Question: Describe this figure in one sentence.
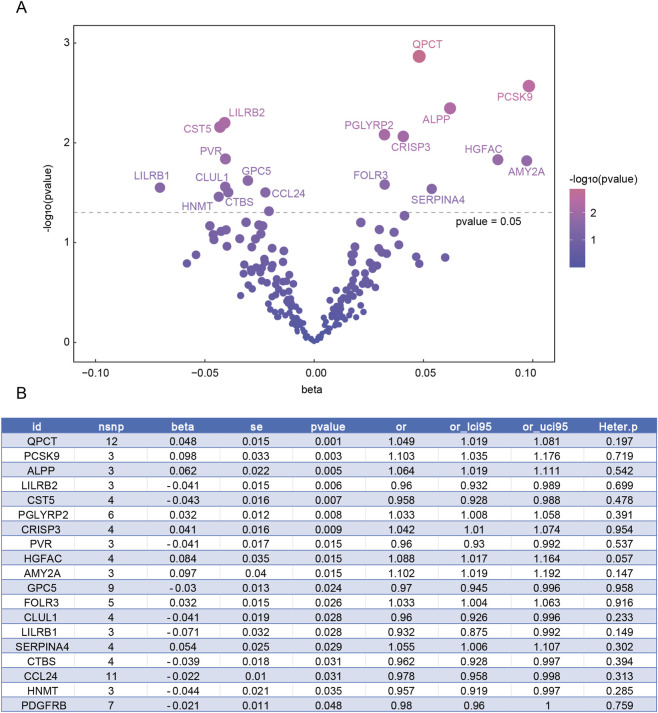
Answer: Protein–metabolite MR results for plasma proteins associated with N-acetyl-L-glutamine levels. (A) Volcano plot of MR effect estimates and P values. (B) Summary of the 19 nominally associated plasma proteins. Plasma proteins were treated as exposures and N-acetyl-L-glutamine levels as the outcome.